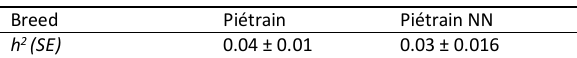
Table 4. Estimated heritabilities ( h 2 ) and corresponding standard errors (SE) of ABC parameter in Pie